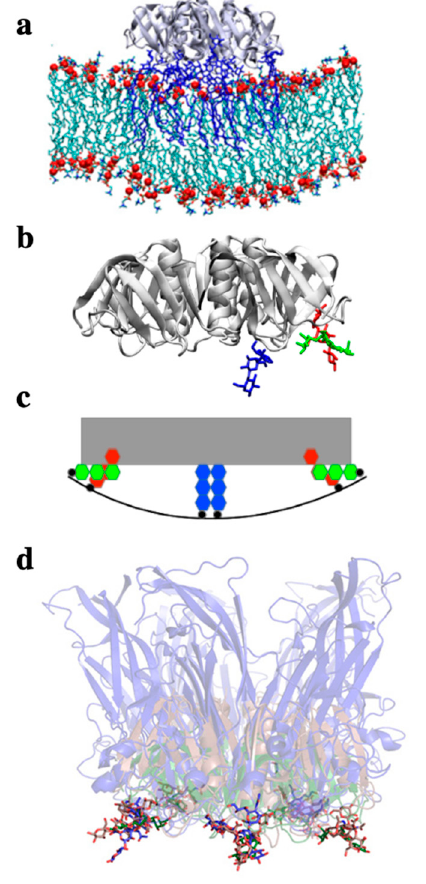
Figure 5. Negative curvature induction based on the geometry of GSL binding sites on lectins. ( a ) All atom molecular dynamics simulation of the STxB homopentamer (gray ribbon structure, side view) on a membrane patch. Gb3 molecules in blue. Note the increment of spontaneous membrane curvature that is observed in silico due to the presence of STxB. ( b ) Representation (extracted from ( a )) of STxB (side view) with three carbohydrates (blue, green and red). For simplicity, only the three Gb3 binding sites on one monomer are shown. Note that sites 1 (red) and 2 (green) are at the periphery of the protein, while site 3 (blue) faces down under the protein. ( c ) Schematic representation of the situation in ( b ) which illustrates that the membrane (black line) needs to bend up at the edges of STxB to plug the sugars of Gb3 receptor molecules (red and green) into the binding pockets of sites 1 and 2. This would then lead to the generation of negative membrane curvature. ( d ) Overlay of the structures of the following proteins in interaction with GSL receptor analogues: STxB in green with Gb3 (Reference [53]), CTxB in red with GM1 (Reference [54]), the capsid protein VP1 from SV40 in blue (Reference [55]). Note that despite the fact that these proteins do not have any sequence similarity, they fold such that the conserved GSL binding site 2 is presented with the same geometry in space (the sugars of the three structures overlay). It therefore seems likely that this fold was selected by convergent evolution for the same function: to generate negative membrane curvature for building endocytic sites for clathrin-independent endocytosis. Reproduced with permission from Toxins, Ref. [24] .